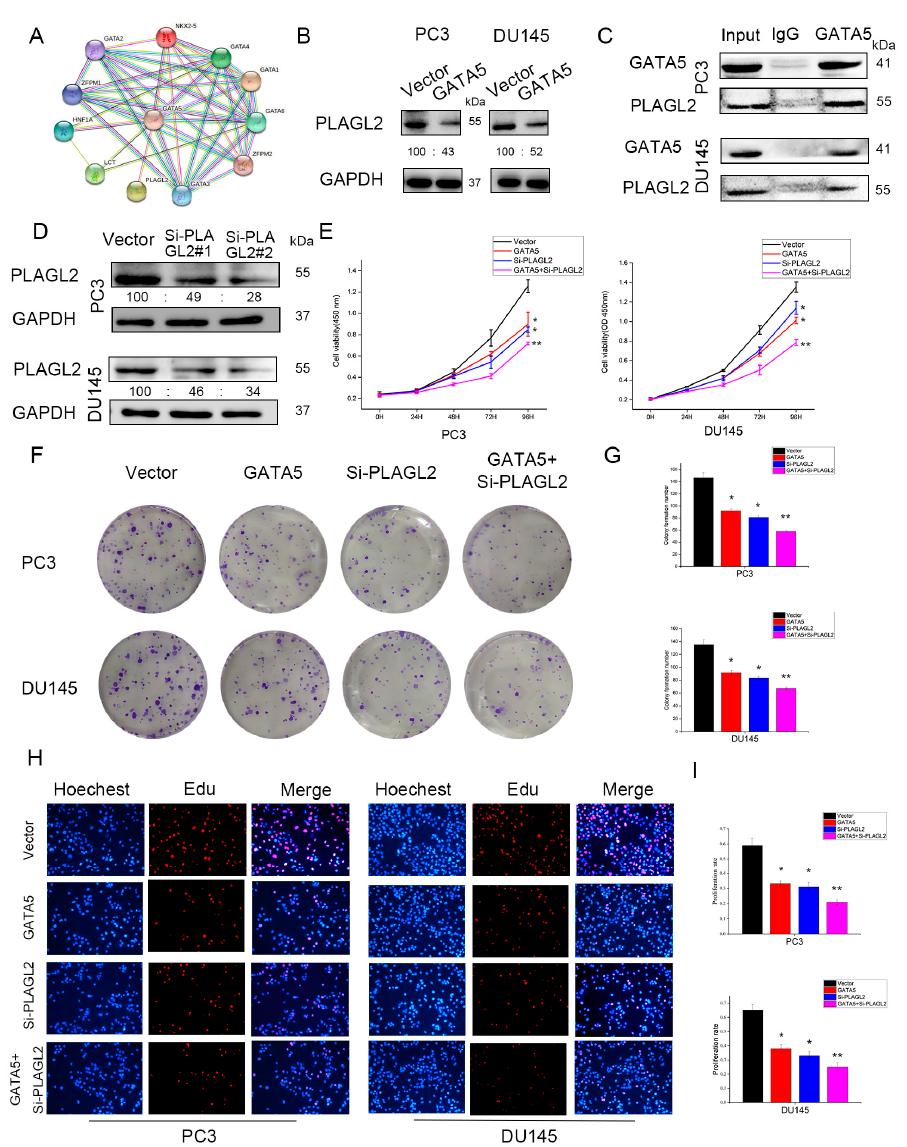
Figure 6. GATA5 inhibits PCa cell proliferation by regulating PLAGL2. ( A ) STRING analysis showed that GATA5 interacted with PLAGL2. ( B ) The expression of GATA5 was negatively correlated with PLAGL2 according to the Western blotting. ( C ) Co-immunoprecipitation indicated the interaction between GATA5 and PLAGL2. ( D ) The effect of PLAGL2 knockdown was verified by Western blotting. ( E – I ) The CCK-8 experiment, colony formation experiment, and EdU experiment were utilized to compare the viability in different groups of PC3 and DU145 cells. Data are presented as mean ± SD of at least three experiments. * p < 0.05 and ** p < 0.01.